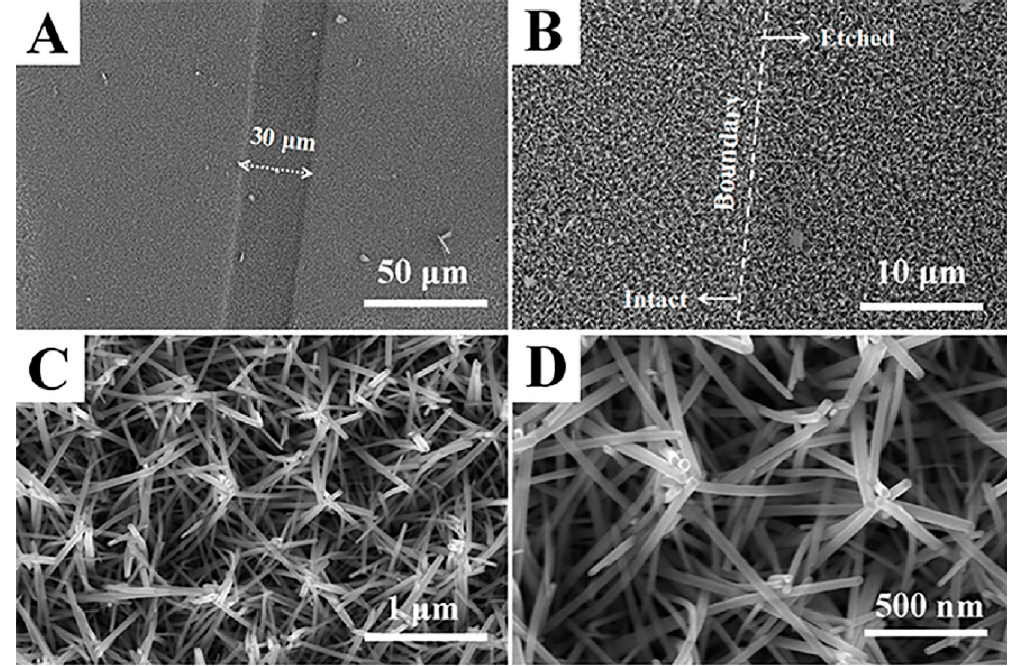
Figure 2. SEM images of ZnO NCs arrays at ( A ) 1000×, ( B ) 5000×, ( C ) 50,000× and ( D ) 100,000× magnification.